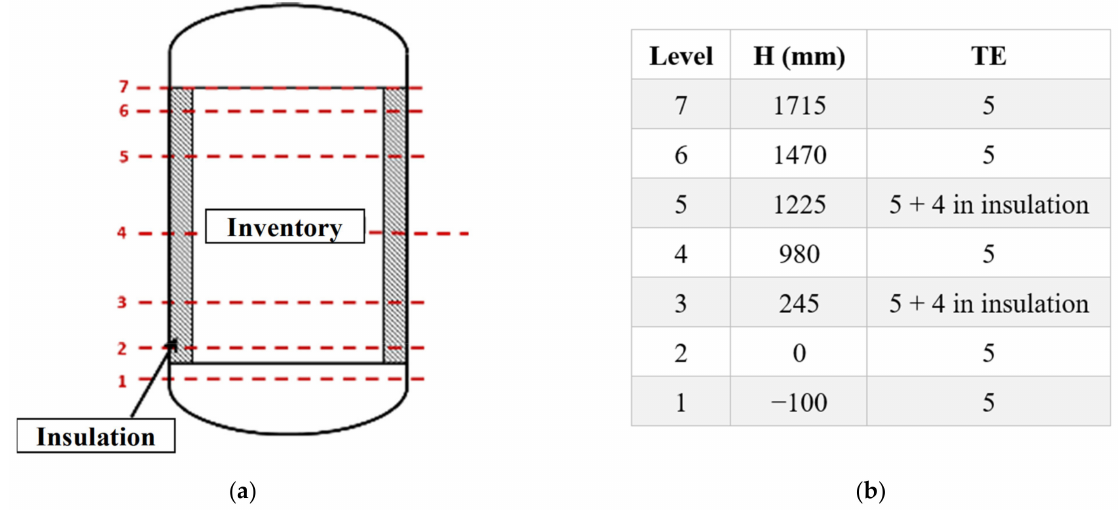
Figure 20. Measurement setup: ( a ) measurement levels in the drawing; ( b ) positions and number of